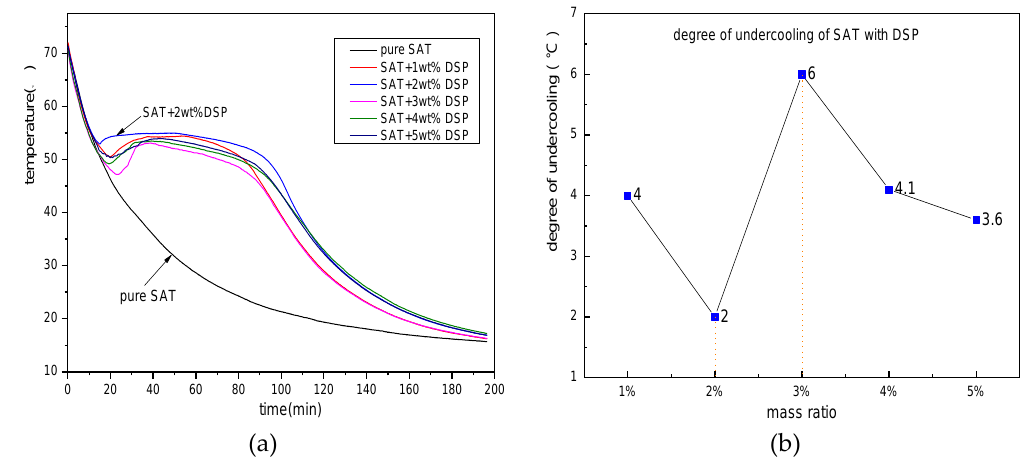
Figure 4. The discharging curves of nucleating agent with different proportions. ( a ) the discharging curves of SAT with DSP; ( b ) distribution of degree of undercooling.